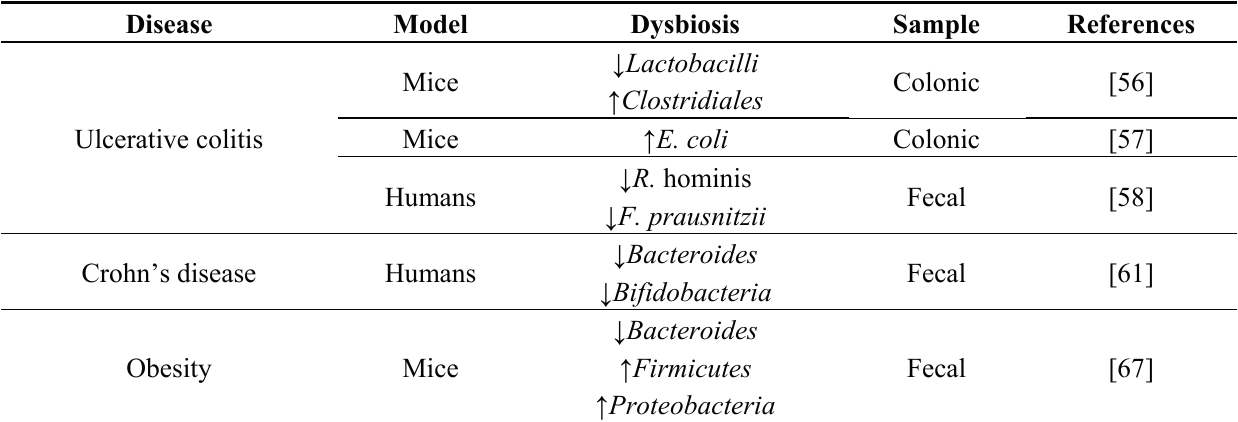
Table 1. Some examples of dysbiosis found in human